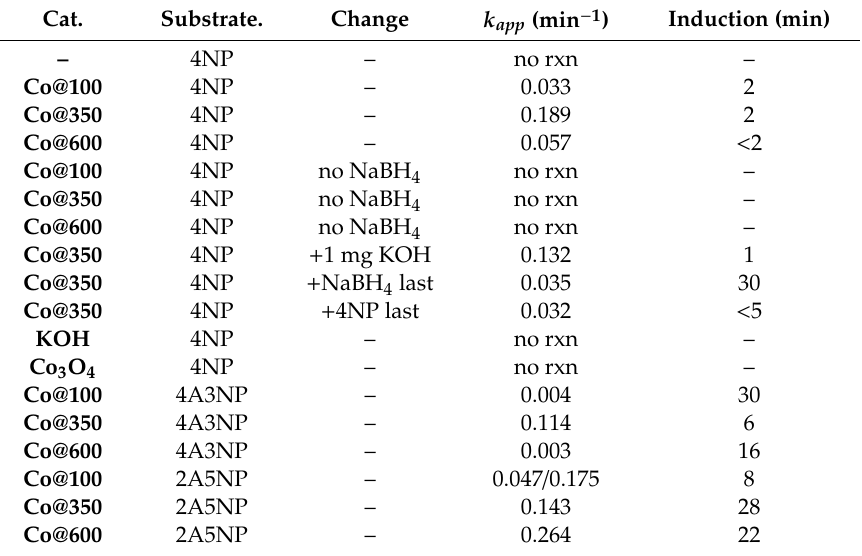
Table 1. Summary of catalytic